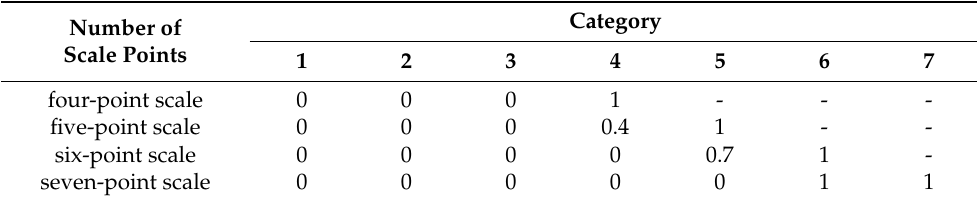
Table 5. Converted score for each point